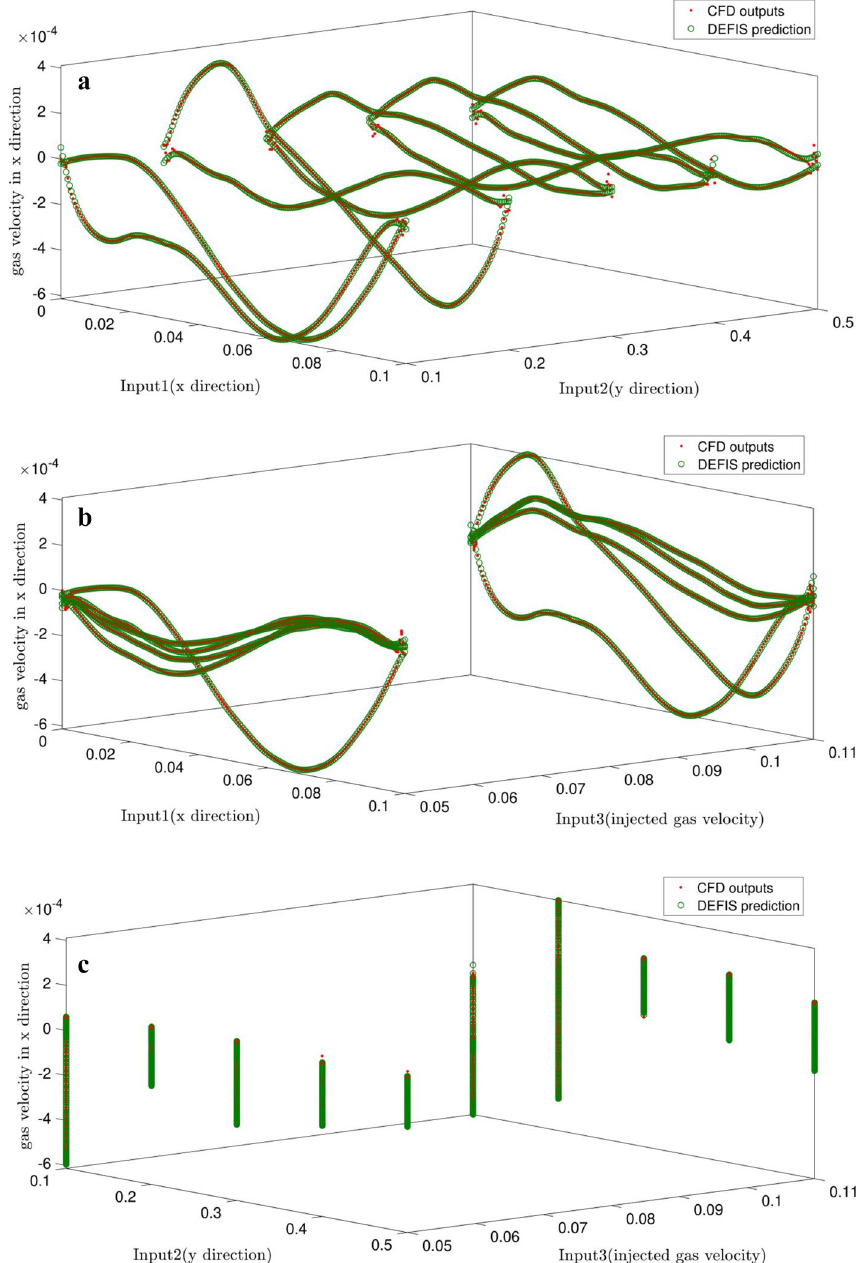
Figure 4. ( a ) Comparison of gas velocity between CFD output and DEFIS prediction with considering first and second inputs. ( b ) Comparison of gas velocity between CFD output and DEFIS prediction with considering first and third inputs. ( c ) Comparison of gas velocity between CFD output and DEFIS prediction with considering second and third